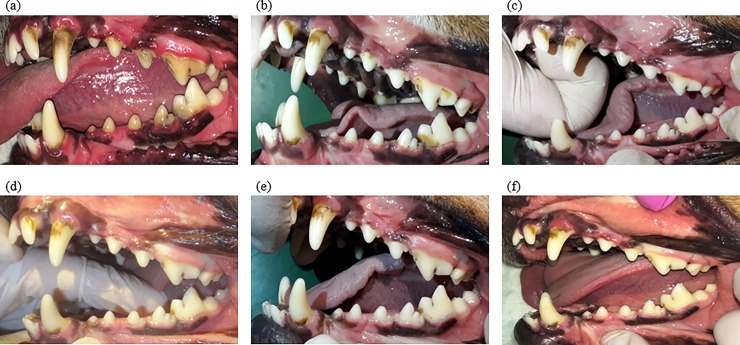
Left dental arcade of the same dog at days 0, 3, 6, 9, 12, and 14 (a–f, respectively) after daily supplementation of autoclaved spongy bone.